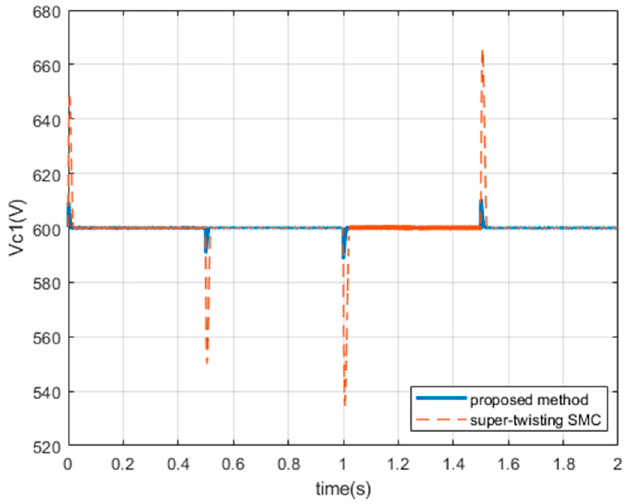
Figure 12. Bus voltage response result of DC microgrid under the two SMC methods.